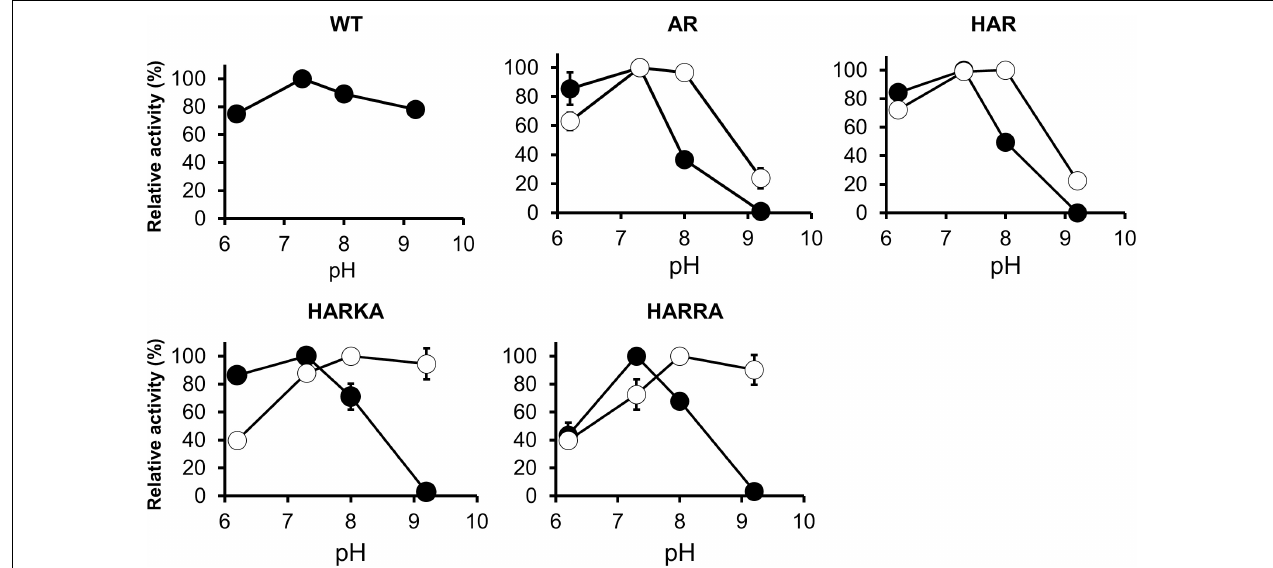
FIGURE 4 | pH dependence profiles of the wild-type and mutant RsPtxD proteins. RsPtxD activity was measured using NAD (filled circles) or NADP (open circles) as substrates. The data are shown as means ± standard deviation obtained from three independent experiments. WT, wild-type; AR, RsPtxD AR ; HAR, RsPtxD HAR ; HARKA, RsPtxD HARKA ; HARRA, RsPtxD HARRA .